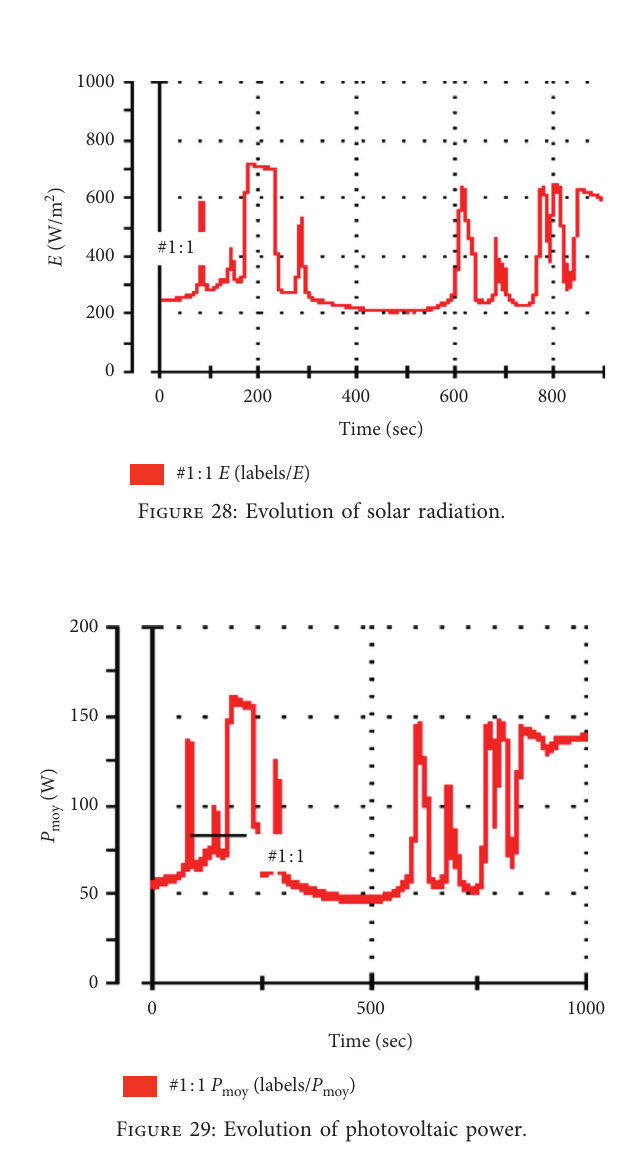
Figure 27: Evolution of temperature.